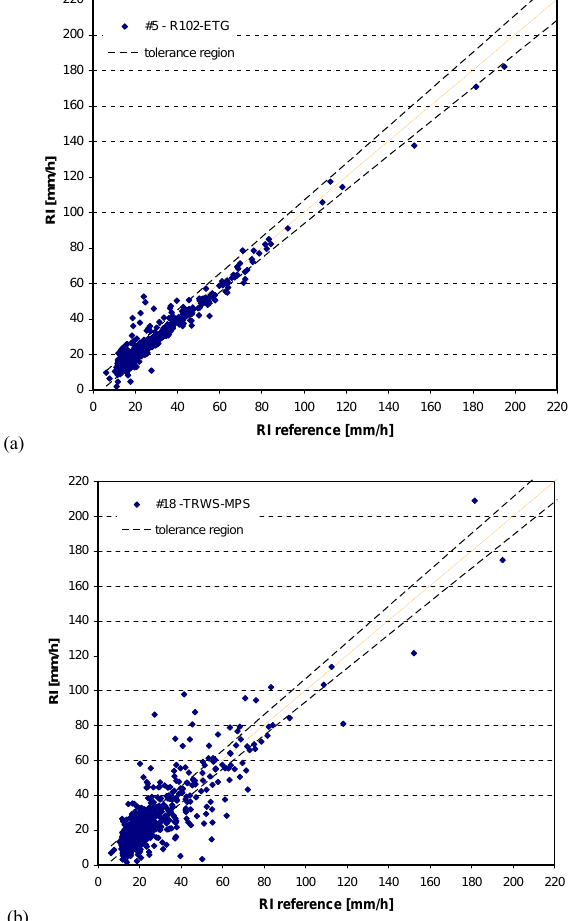
Fig. 5 : Scatter plots of measured rainfall rates against the reference ones (from the data sheets in Vuerich et al., 2009a), illustrating the dispersion of deviations around the fitted trend lines for two sample gauges with a high (a) and low (b) R 2 value as reported in Table 2.